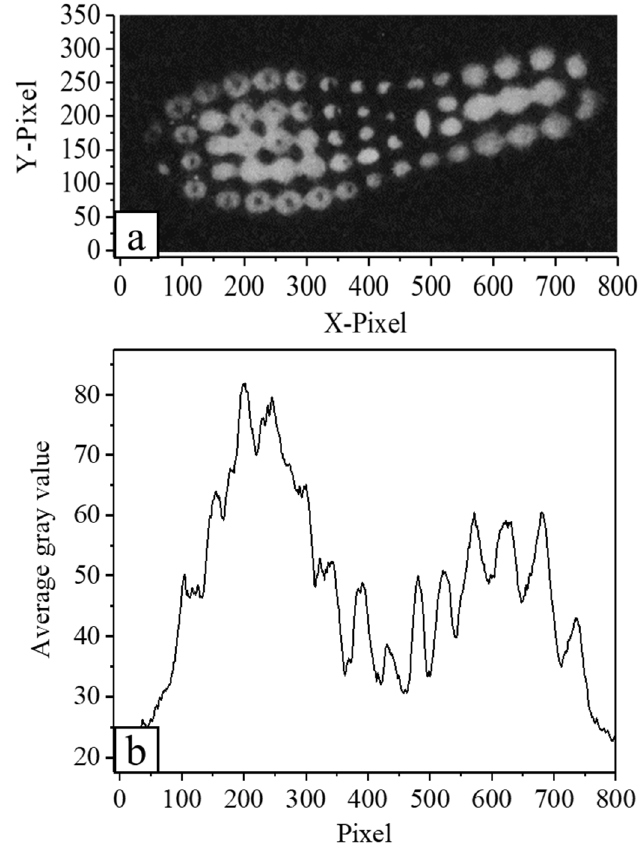
Figure 4. Gray map of single footprint features. ( a ) Gray-scale fluorescence image of a contaminated floor panel. ( b ) Plot showing the change in the average fluorescence gray value across the horizontal pixel points corresponding to ( a ).